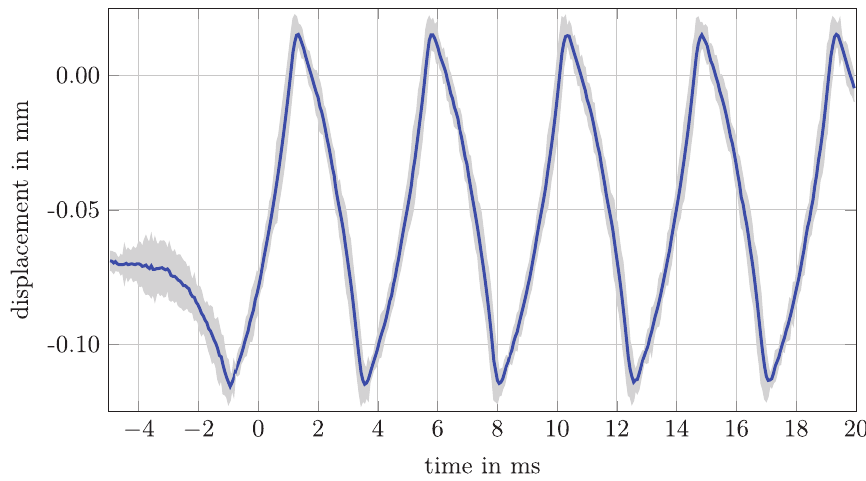
Figure 3. Mean signal and 99.73% con fi dence bound from ten measurements. The string is excited in the middle of the string and measured at a position 15 mm beside the